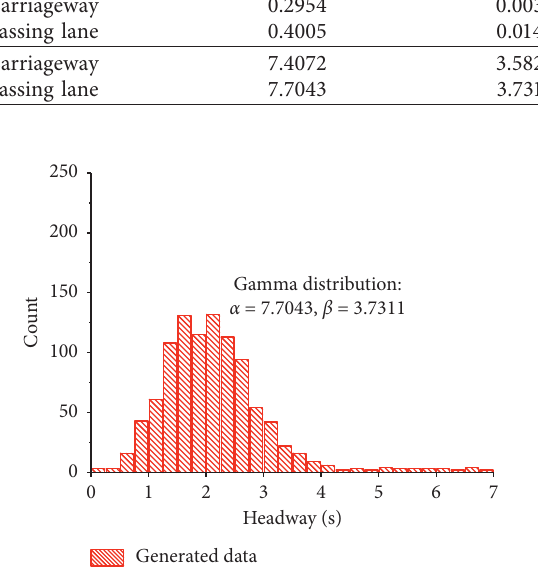
Figure 15: Vehicle headways of dense flow in passing lane.